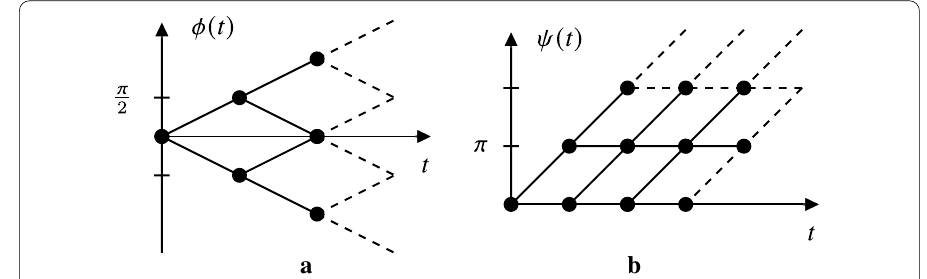
Fig. 2 CPM trellis (left) and its tilted version (right), M cpm = 2 , h = 1 2 , φ 0 = 0 , L cpm = 1 and rectangular frequency